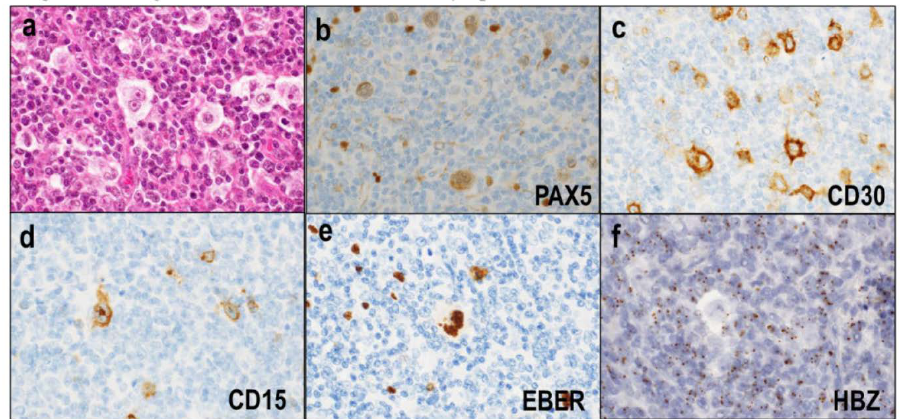
Figure 7. Hodgkin-like adult T-cell leukemia/lymphoma. ( a ) Small-to-medium-sized lymphocytes with mild nuclear atypia diffusely proliferate with scattered HRS-like cells (HE 400). ( b ) The × HRS-like cells are of the B-cell lineage (PAX5 400). ( c – e ) The HRS-like cells show positive staining × for CD30 ( 400) and/or CD15 ( 400) and are frequently infected by EBV ( 400). ( f ) HRS-like cells × × × are not infected with HTLV-1 ( 400). ×